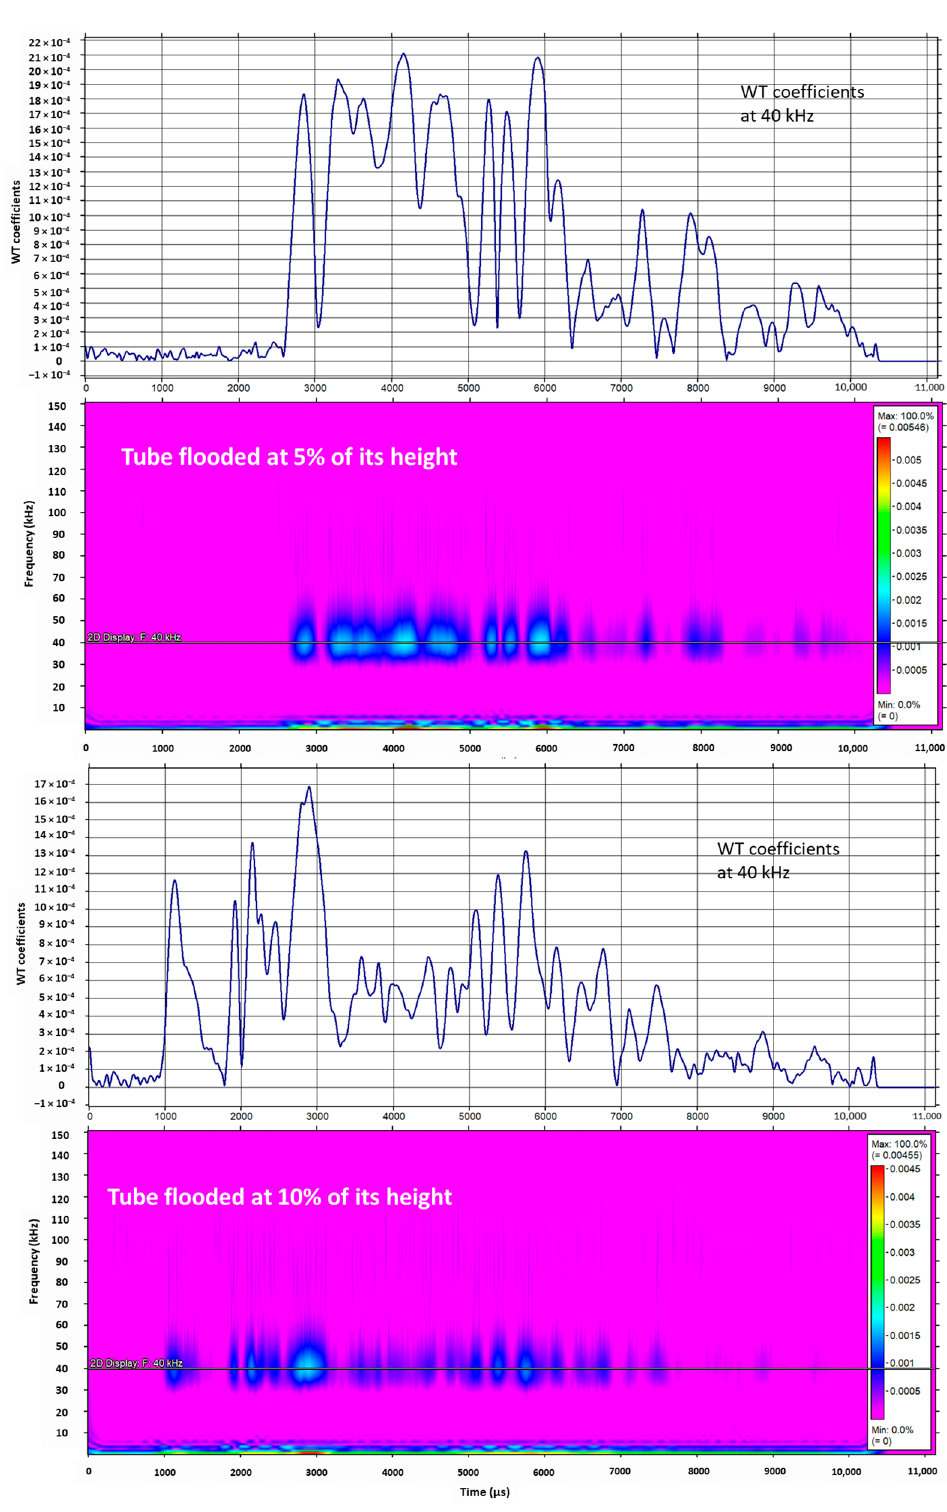
Figure 8. Wavelet coefficients and their spectrogram for a received guided wave pulse centered at 40 kHz using the experiment setup with the tube dry and the tube flooded at 5% and 10% of its height.